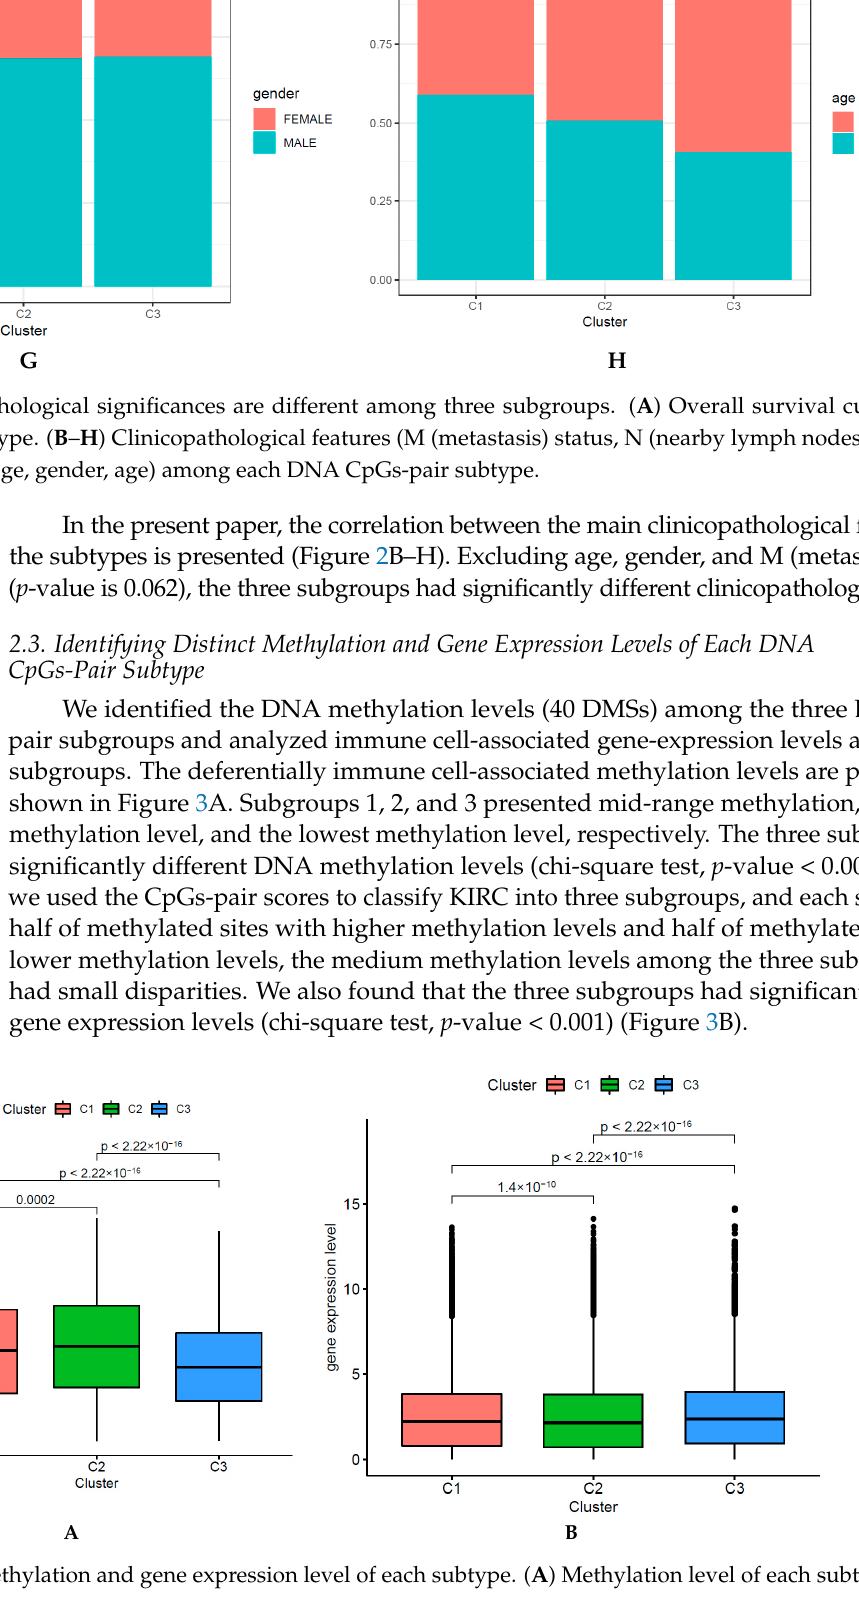
Figure 3. Distinct DNA methylation and gene expression level of each subtype. ( A ) Methylation level of each subtype. ( B ) Gene level of each